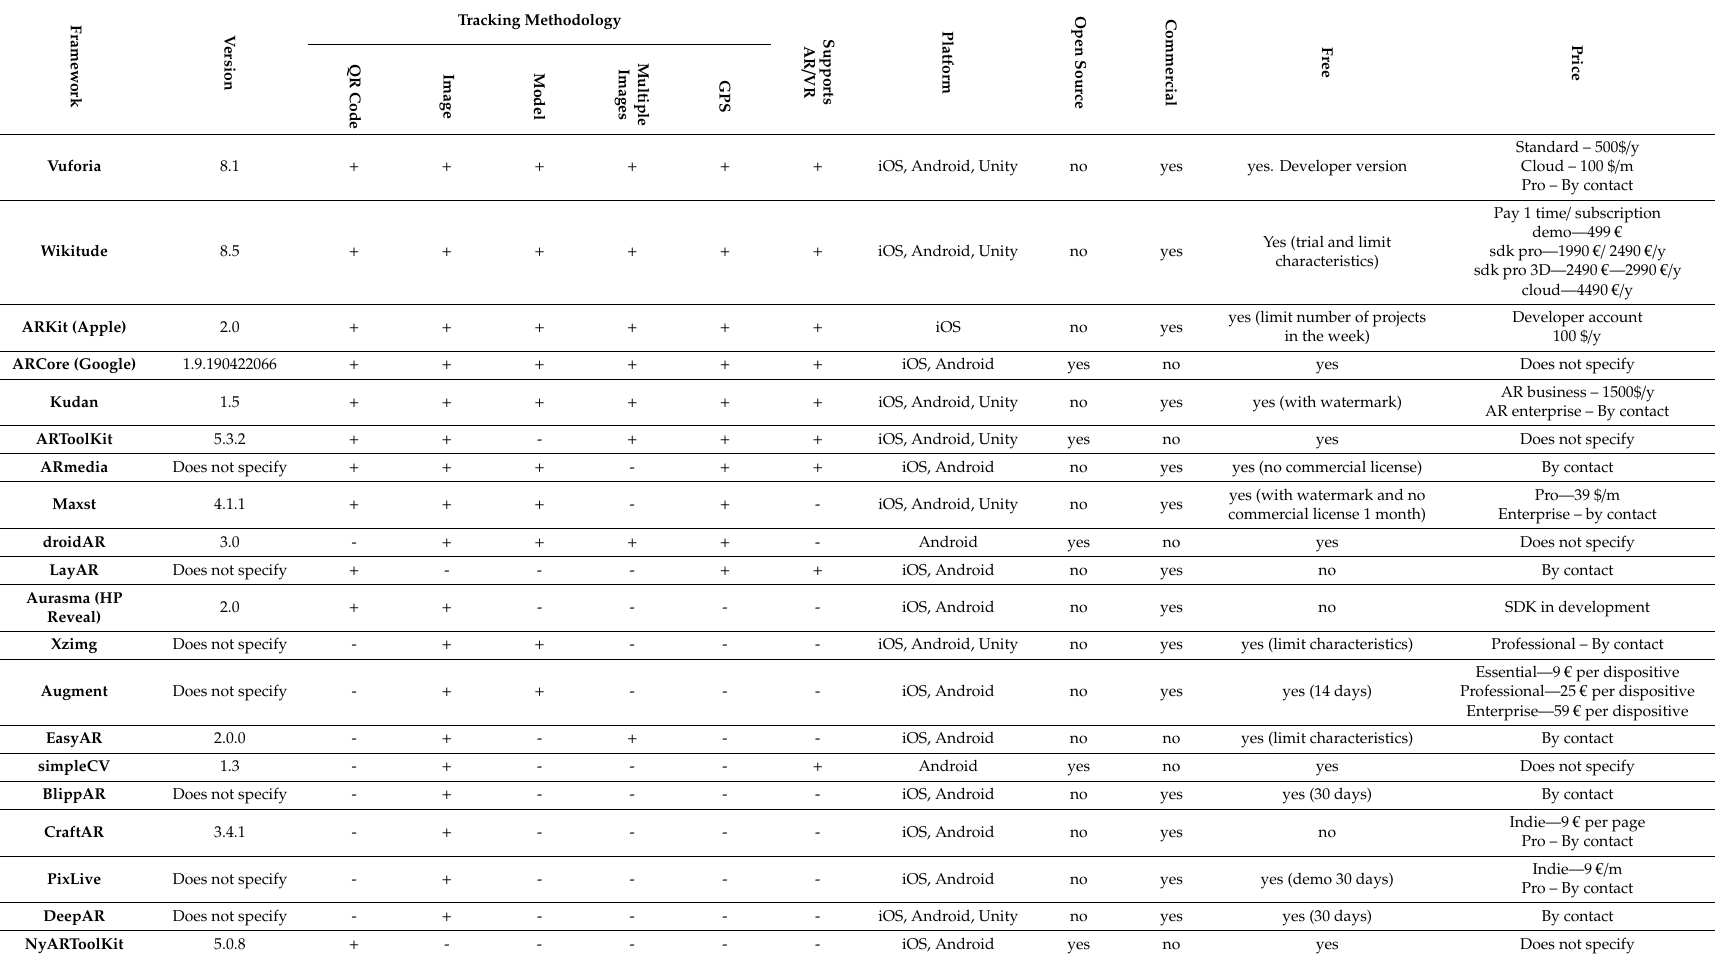
Table 2. Comparative table of AR